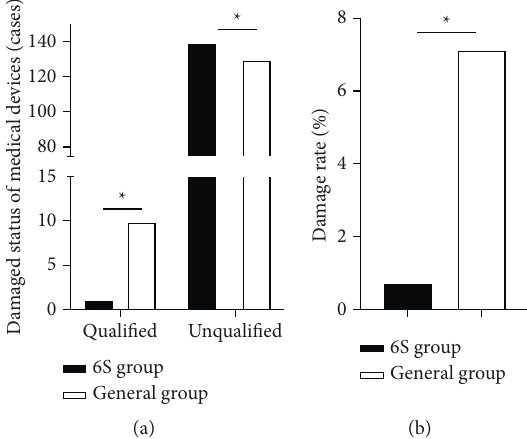
Figure 3: Analysis of damage to medical devices in two groups of dentists. (a) The damaged status of medical devices (cases). (b) Damage rate (%). The 6S group compared to the general group, ∗ P > 0 .